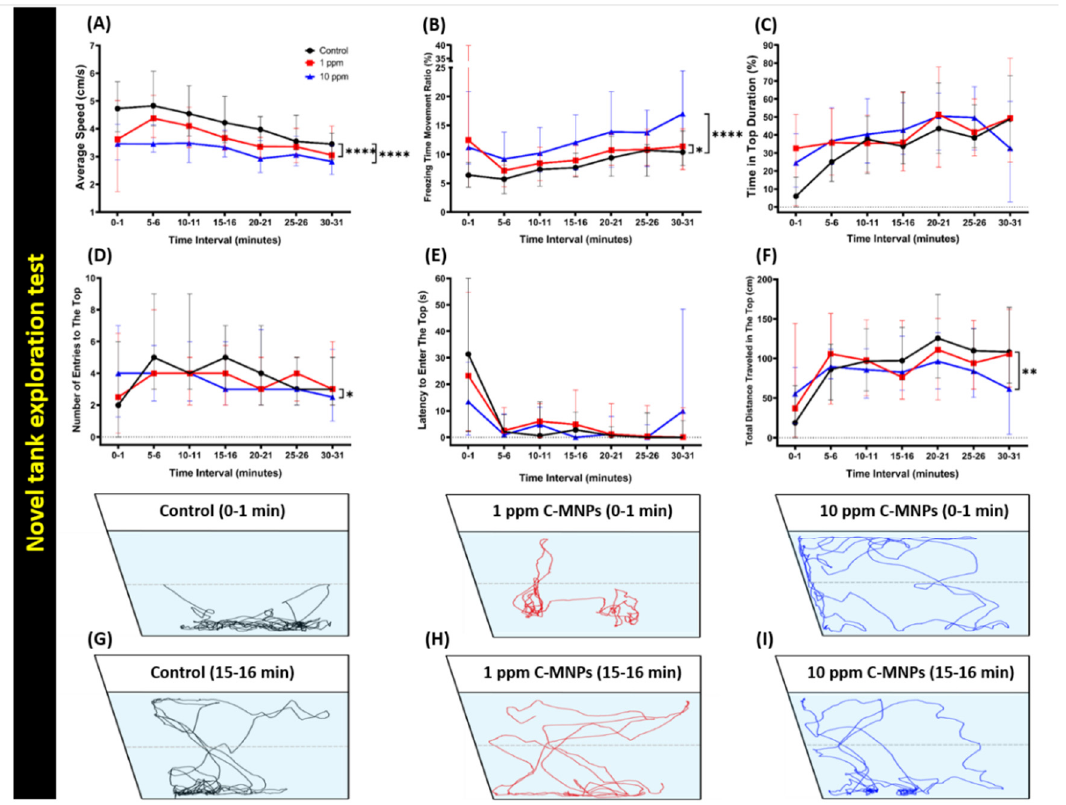
Figure 2. Behavior endpoints of control and carbon magnetic nanoparticles (C-MNPs)-exposed zebrafish in the novel tank test after two weeks’ exposure. ( A ) Average speed, ( B ) freezing time movement ratio, ( C ) time in the top duration, ( D ) the number of entries to the top, ( E ) latency to enter the top, and ( F ) total distance traveled in the top were analyzed. ( G-I ) The locomotor trajectories of control as well as 1 and 10 ppm C-MNPs-exposed fish in the novel tank test. The black line represents the control group, the red line represents the low concentration C-MNPs group (1 ppm), and the blue line represents the high concentration C-MNPs group (10 ppm). The data are expressed as the median with interquartile range and were analyzed by two-way ANOVA with Geisser-Greenhouse correction. To observe the main column (C-MNPs) e ff ect, Dunnett’s multiple comparison test was carried out. ( n = 20, * p < 0.05, ** p < 0.01, **** p <